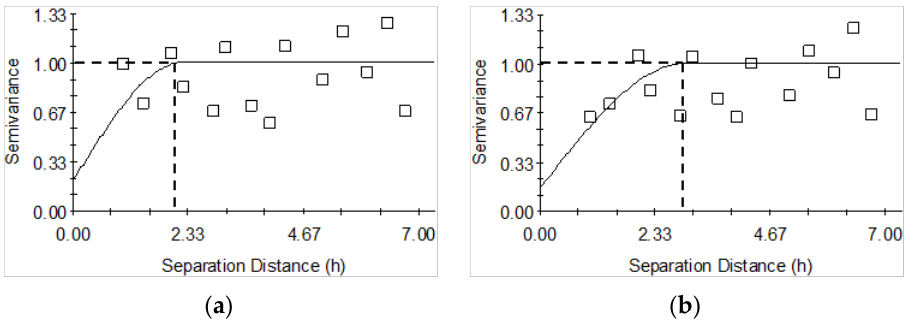
Figure 5. Experimental variograms (shown as small squares) and their fitted models (shown as curves) based on the standardized residuals when: ( a ) no spatial correlation is considered in logistic regression; and ( b ) considering spatial correlation in logistic regression; (a,b) corresponding to the initial and final set of parameters in Table 5, respectively.